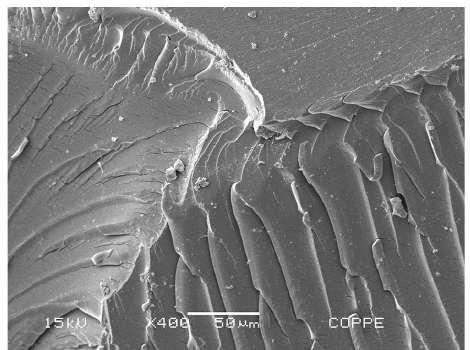
Figure 8. SEM fractograph of a bend tested neat epoxy (400x).